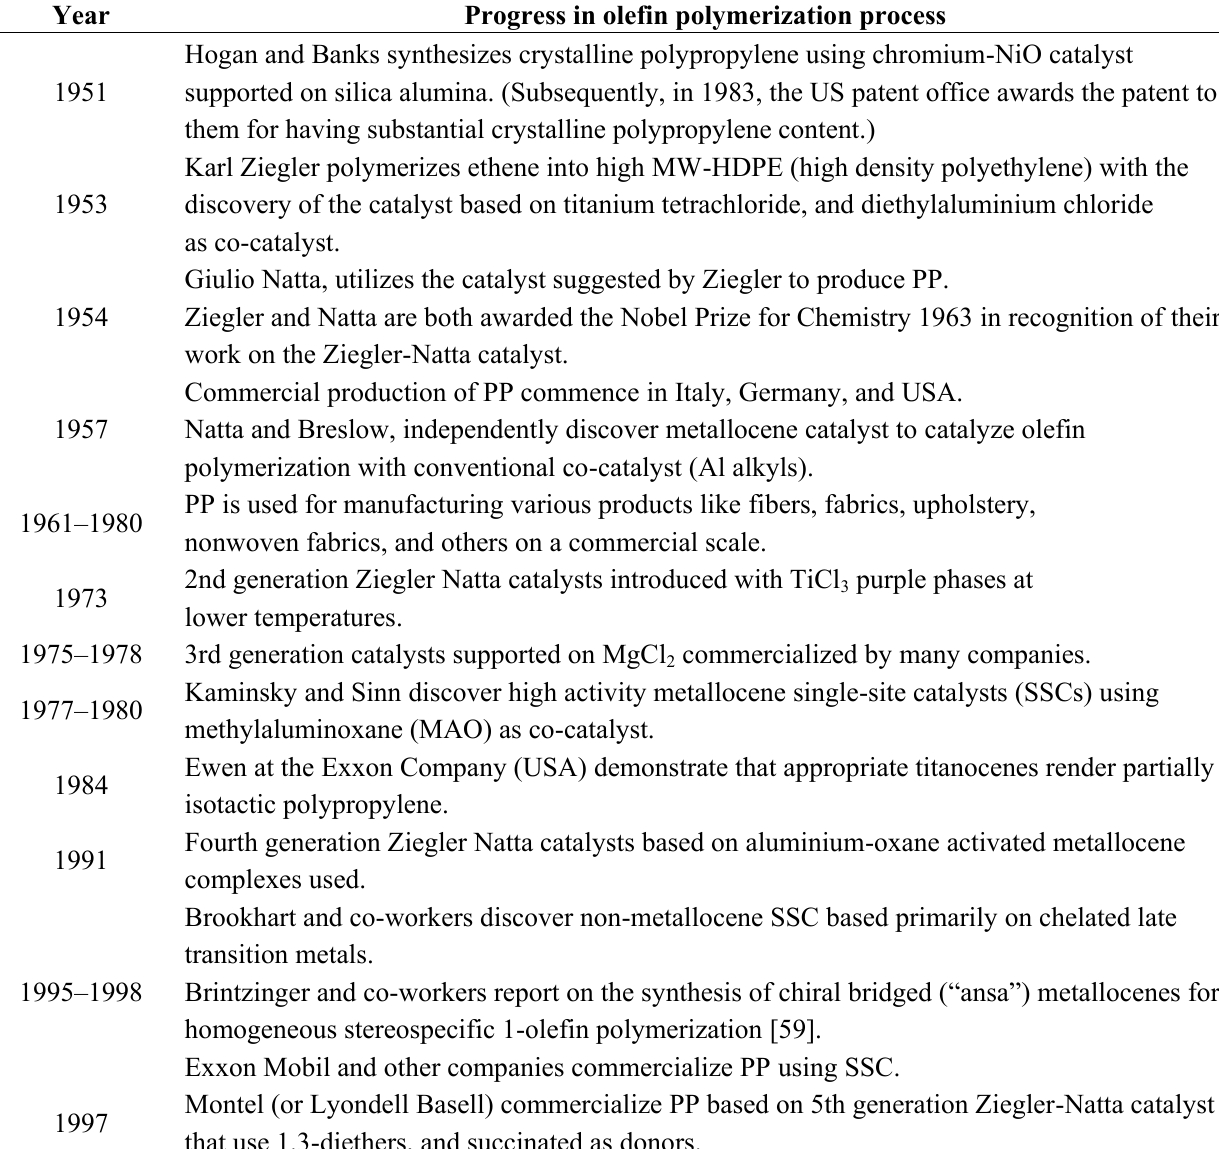
Table 2. Timeline showing the historical progress in the polymerization process of olefin—milestones are represented until the late 20th